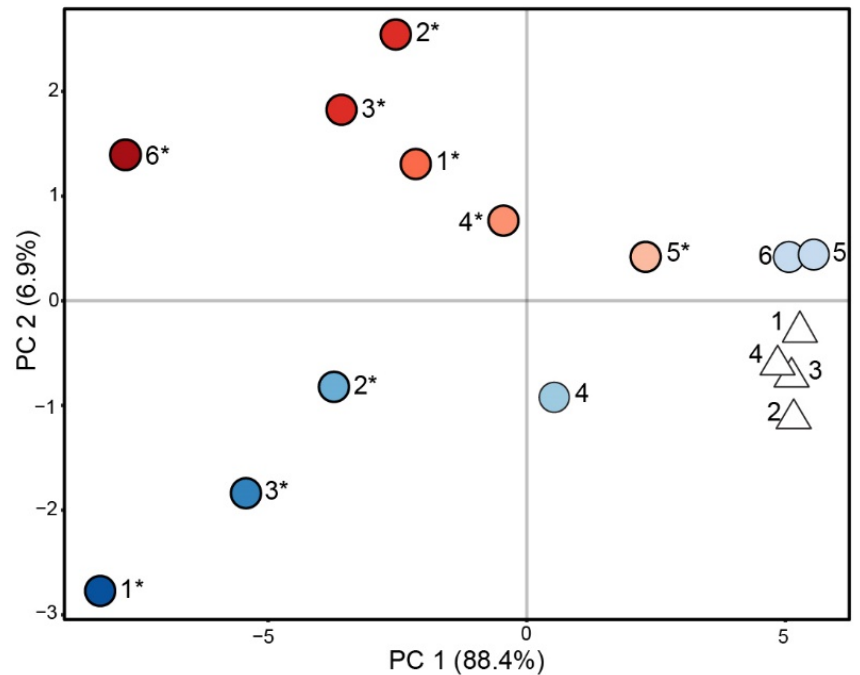
Figure 2. Differences in total cytokine production are the dominant source of variance driving separation of the mice in a Valley fever infection model. A principal component analysis (PCA) score plot of 16 mice inoculated with C. immitis RS (blue circles, n = 6), C. posadasii Silveira (red circles, n = 6) or PBS (white triangles, n = 4) as observations, using 26 cytokines as variables shows that total cytokine abundance separates the mice on PC1, representing the majority of the total variance. The color gradient in the observation markers indicates total cytokine abundance, with the darkest colors indicating the highest abundance; mice with disseminated disease are indicated with an asterisk (*). Differences in the cytokine profiles between RS and Sil, represented on PC2, are small in comparison. The volatile compounds present in the BALF samples were collected using solid-phase microextraction (SPME) and analyzed using two-dimensional gas chromatography coupled with time-of-flight mass spectrometry (GC × GC-TOFMS). After contaminant removal and data cleanup, we detected 91 VOCs (Supplemental Table S3), of which 26 were identified at level 1 or 2 [22] and assigned putative compound names based on mass spectral and chromatographic data (Table 1). Of the 26 named compounds, 19 have been previously associated with human and environmental fungal pathogens, including decanal, which was detected in the in vitro cultures of Coccidioides spp. [32] (Table 1). For the unnamed compounds, 16 were identified at level 3 and assigned chemical classification based on a combination of mass spectral and chromatographic data (Supplemental Table